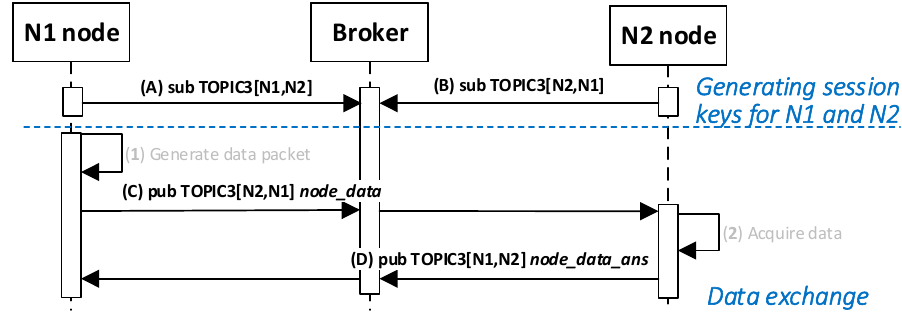
Figure 34. The sequence diagram of the data exchange in the MQTT service for the procedure of sending data from N1 node to N2 node.